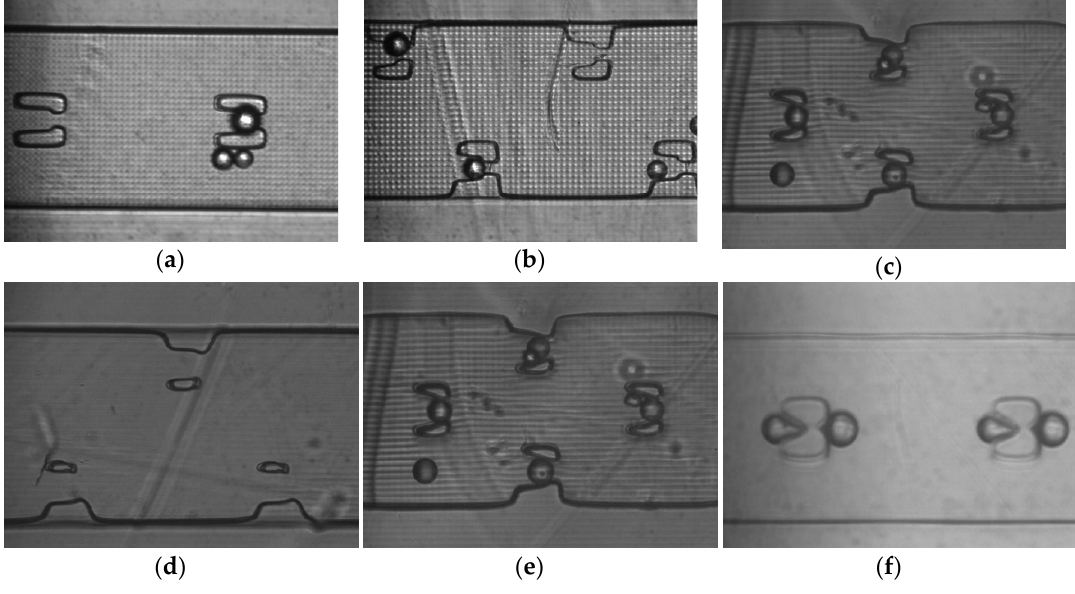
Figure S1: exterior features, ridges, 500 ms exposure; Figure S2: exterior features, ridges, 1000 ms exposure; Figure S3: exterior features, ridges, 1500 ms exposure; Figure S4: exterior features, trenches with edge compensation, 500 ms; Figure S5: exterior features, trenches with edge compensation, 1000 ms; Figure S6: exterior features, trenches with edge compensation, 1500 ms; Figure S7: exterior features, trenches without edge compensation, 500 ms; Figure S8: exterior features, trenches without edge compensation, 1000 ms; Figure S9: exterior features, trenches without edge compensation, 1500 ms; Figure S10: interior features, ridges, 500 ms; Figure S11: interior features, ridges, 1000 ms; Figure S12: interior features, ridges, 1500 ms; Figure S13: interior features, trenches with edge compensation, 500 ms; Figure S14: interior features, trenches with edge compensation, 1000 ms; Figure S15: interior features, trenches with edge compensation, 1500 ms; Figure S16: interior features, trenches without edge compensation, 500 ms; Figure S17: interior features, trenches without edge